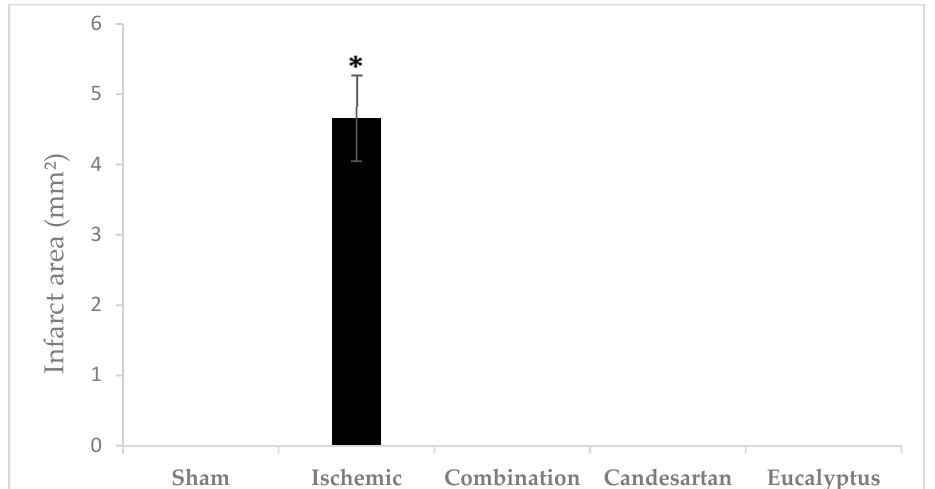
Figure 8. Cerebral infarct area. Cerebral infarct area of the rat brain sections stained by TTC 14 days after right common carotid artery ligation for Sham (n = 6), Ischemic (n = 11), Ischemic treated with a combination of Candesartan and Eucalyptus (n = 10), Ischemic treated with Candesartan (n = 5), and Ischemic treated with Eucalyptus (n = 5) groups. * p < 0.05 for a significant difference between Ischemic and Sham groups. The bar represents the mean ± SEM (Standard error of the mean).